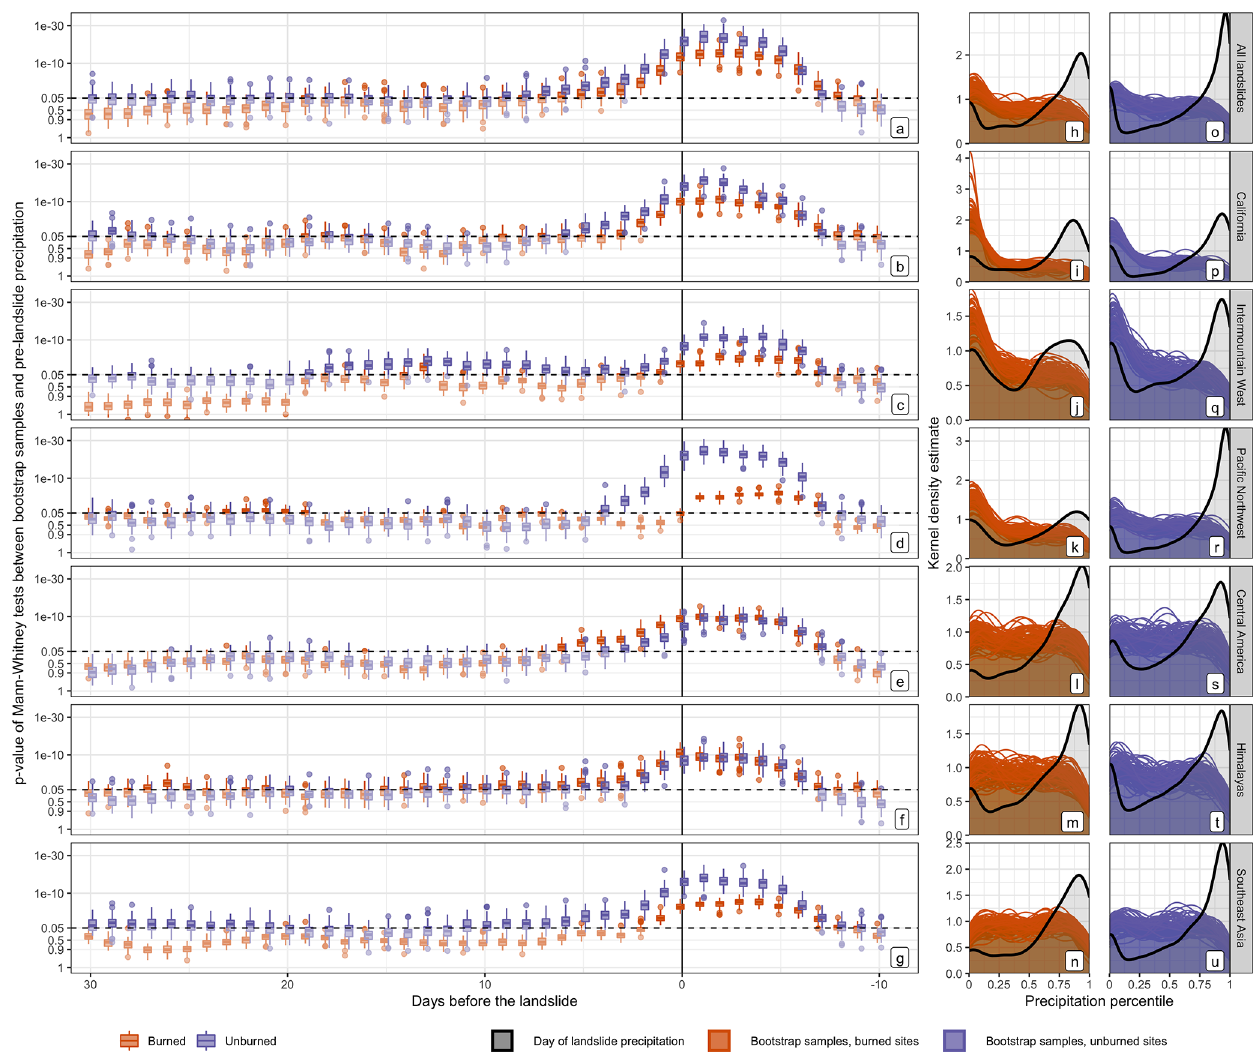
Figure 6. p values of Mann–Whitney hypothesis tests comparing mass-movement-triggering precipitation relative to 100 bootstrapped samples ( n ≈ 100 for each sample) drawn from a 38-year precipitation record from the mass movement locations. The y axes are shown with a probit transform to expand the section of the axis where p values are below 0.05 (significant at 95% confidence, shown as a dashed black line). The y axis has also been inverted so that larger differences in precipitation (lower p values) are higher on the y axis for consistency with the percentile plots in Fig. 3. In panels (h) – (u) , an example of the kernel density estimate (kde) for day-of-landslide precipitation in black separated by burned and unburned groups is compared with kde’s of all bootstrapped samples in orange (burned group) or purple (unburned